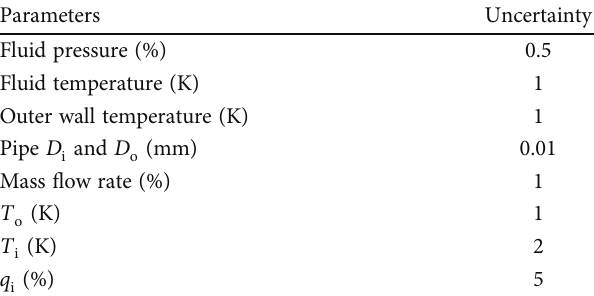
Table 3: Summary of the